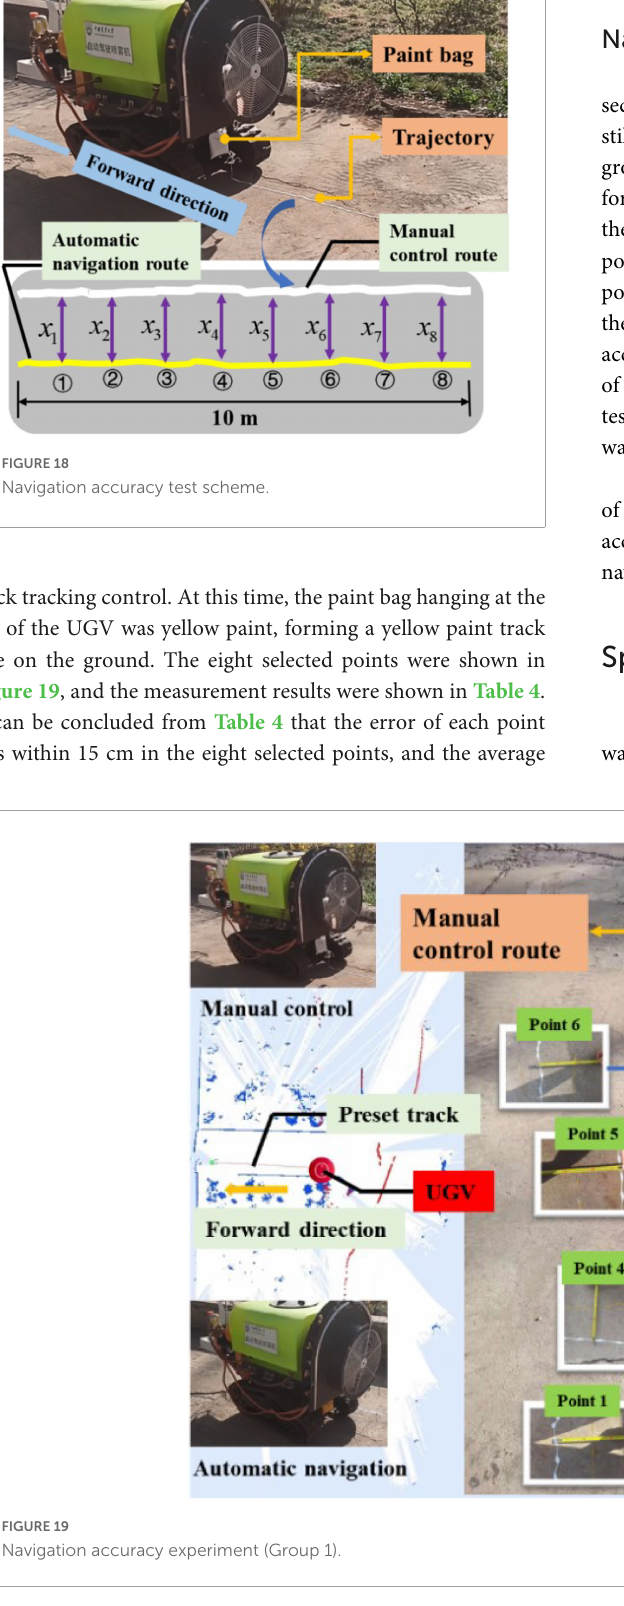
FIGURE19 Navigation accuracy experiment (Group